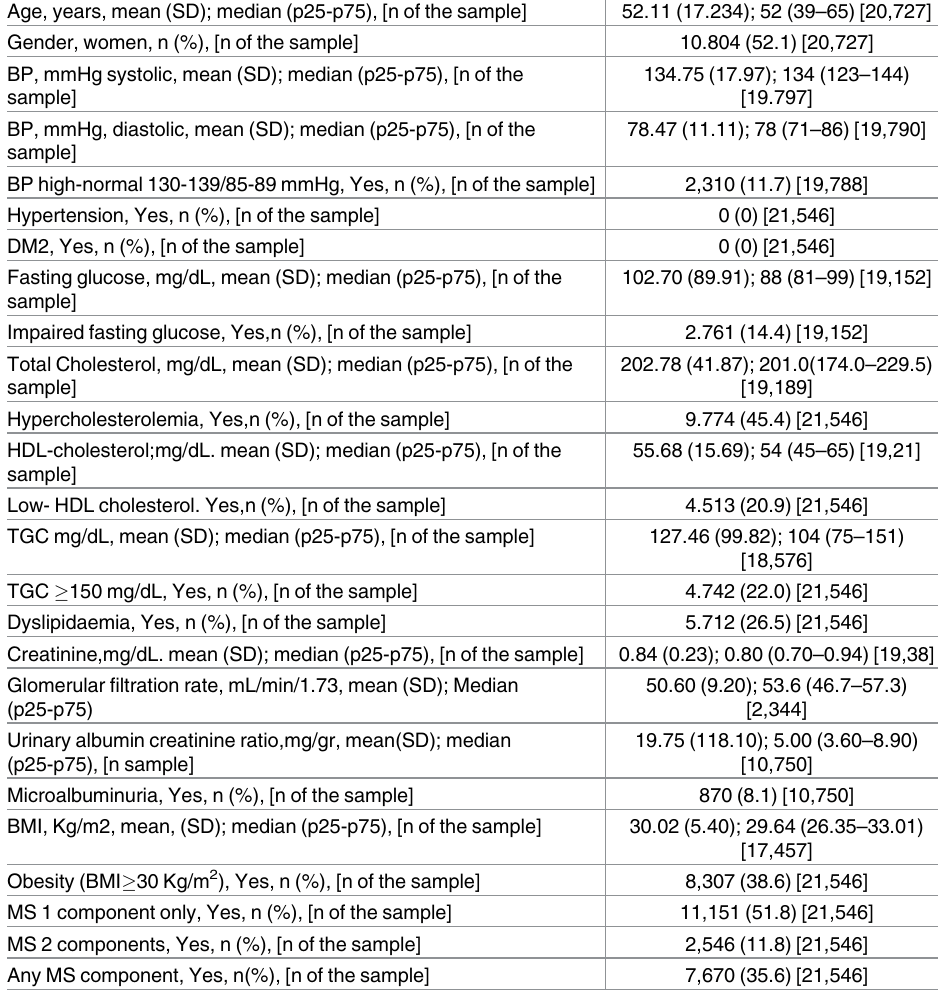
Table 1. Baseline characteristics of cohort participants,